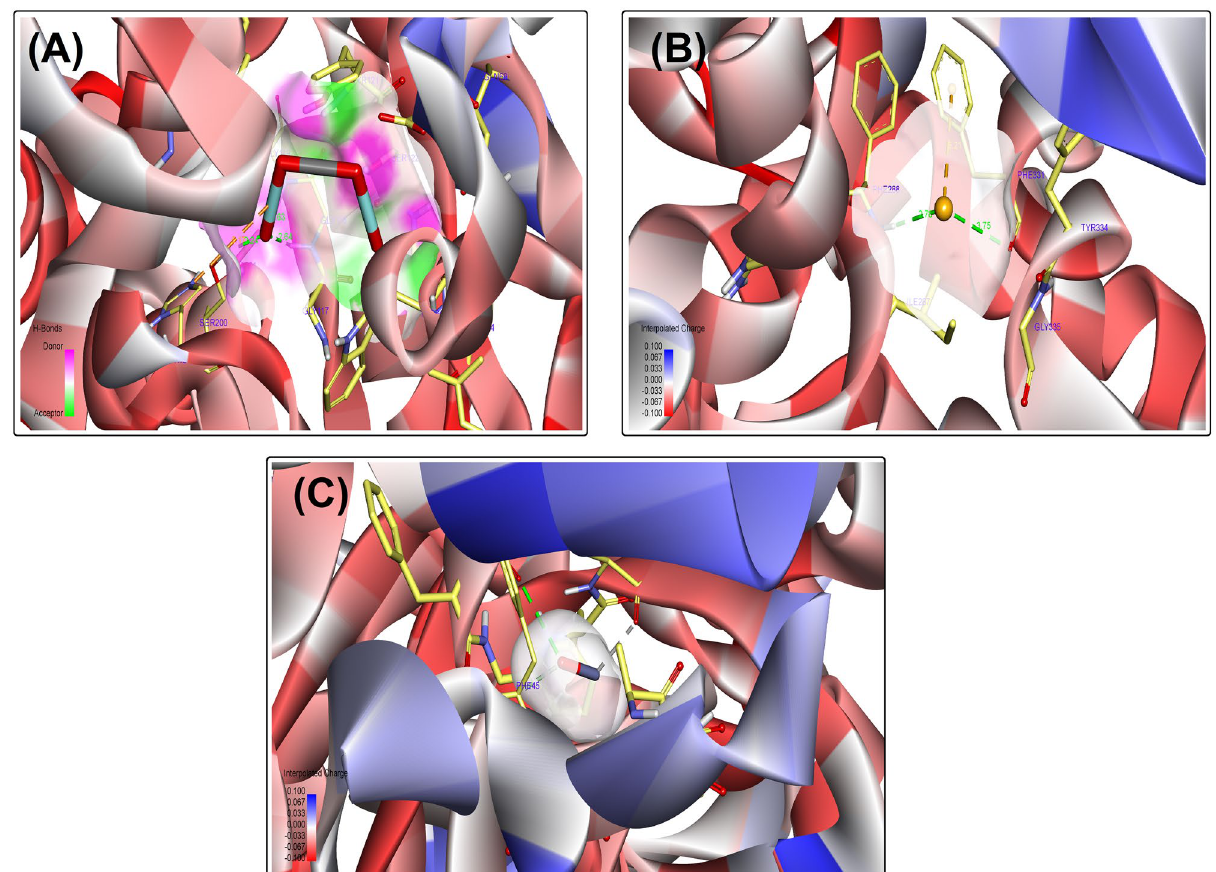
Figure 5. 3D interaction of CoFeNPs ( A ), SeNPs ( B ), and ZnONPs ( C ) in the active site of acetylcholinesterase